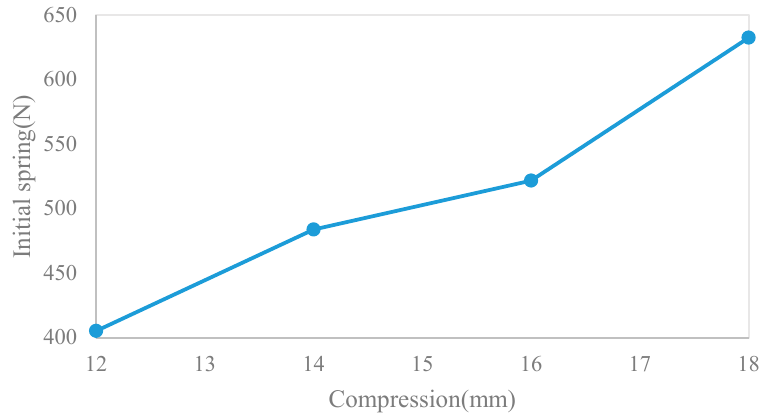
Figure 4. Distribution of compression—elastic force.